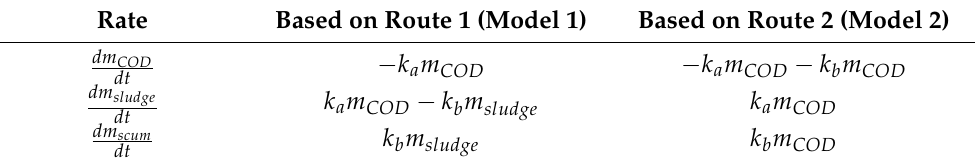
Table 2. Summary of the mathematic equations used in the mechanistic models based on routes 1 and